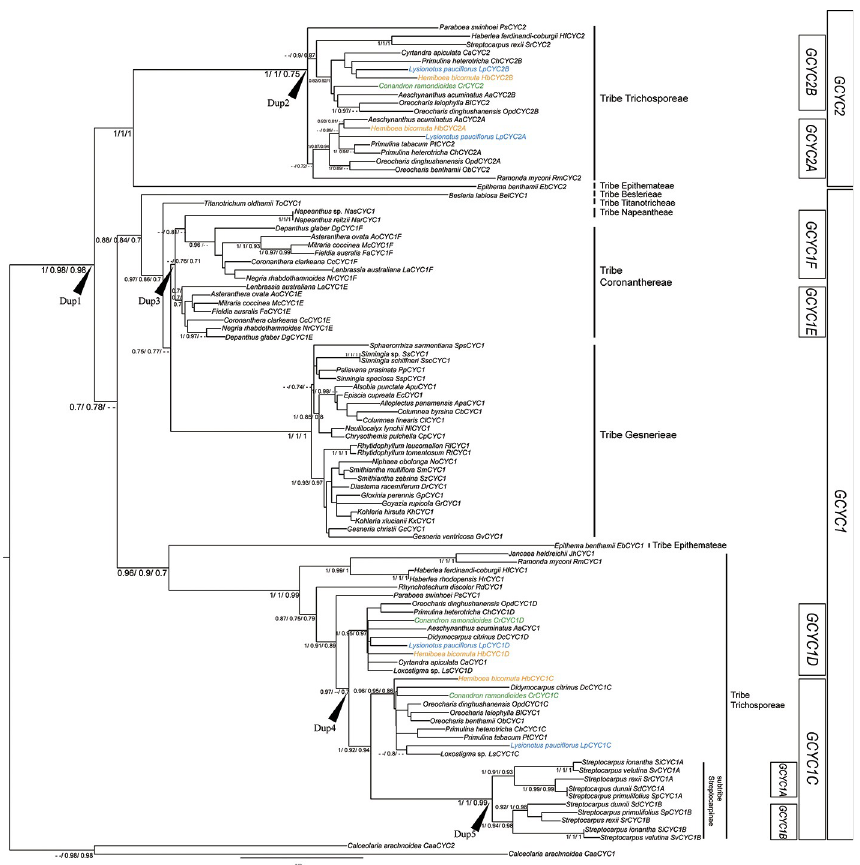
Fig 3. Genealogy and duplication events of GCYC in Gesneriaceae. Phylogram derived from a Maximum Likelihood (ML) analysis showing average branch lengths. Numbers along branches are BI, ML approximate likelihood value (aLRT), and ML bootstrap values. (--) indicates branch support value lower than 0.7 either in either BI, aLRT or ML bootstrap. GCYC copies of species used for expression studies are colored: Conandron ramondioides (light green); Hemiboea bicornuta (orange); Lysionotus pauciflorus (light blue). Dup1 to Dup5 indicate inferred duplication events.